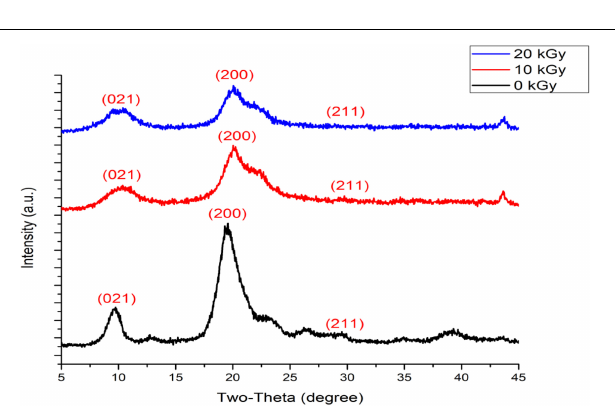
FIGURE 3 | X-ray diffraction (XRD) of chitosan with irradiation at three different irradiations (0–20